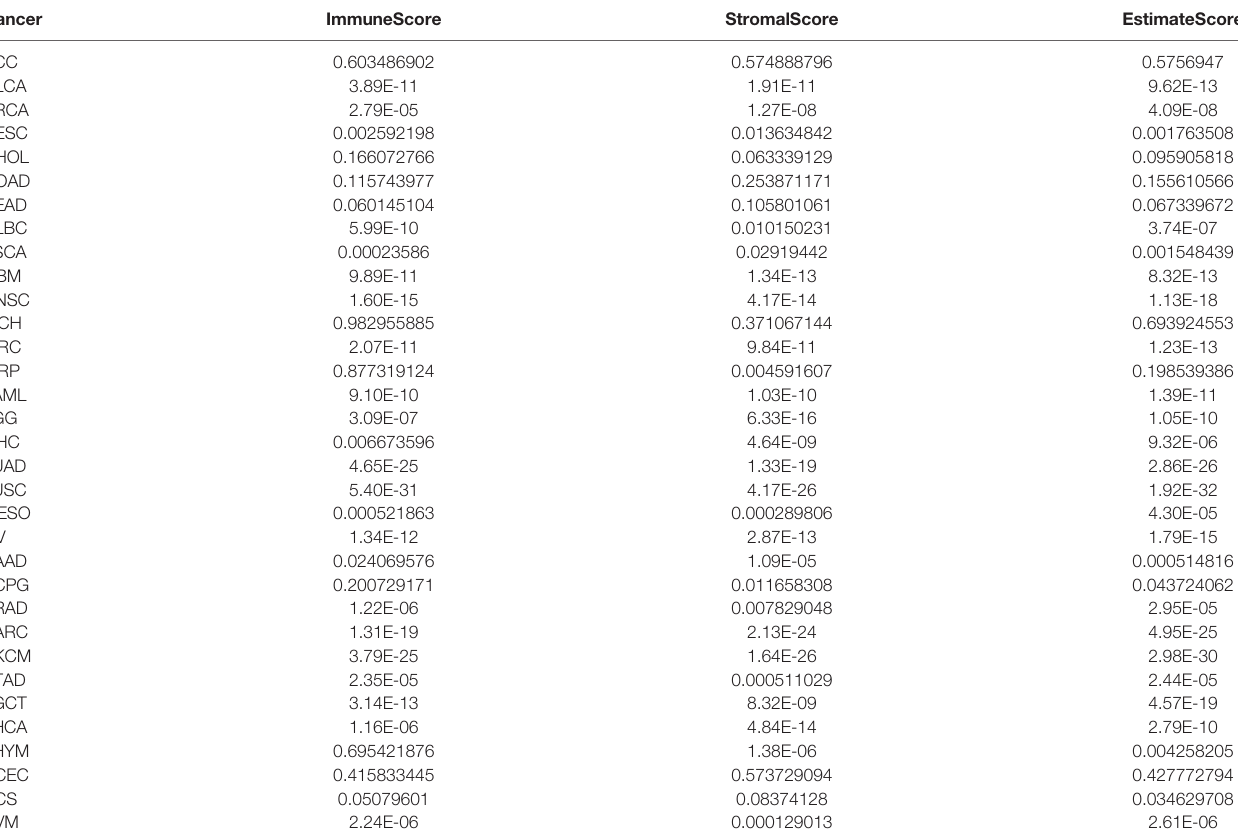
TABLE 2 | Correlation of NAAA expression with ImmuneScore and StromalScore analysis. Cancer